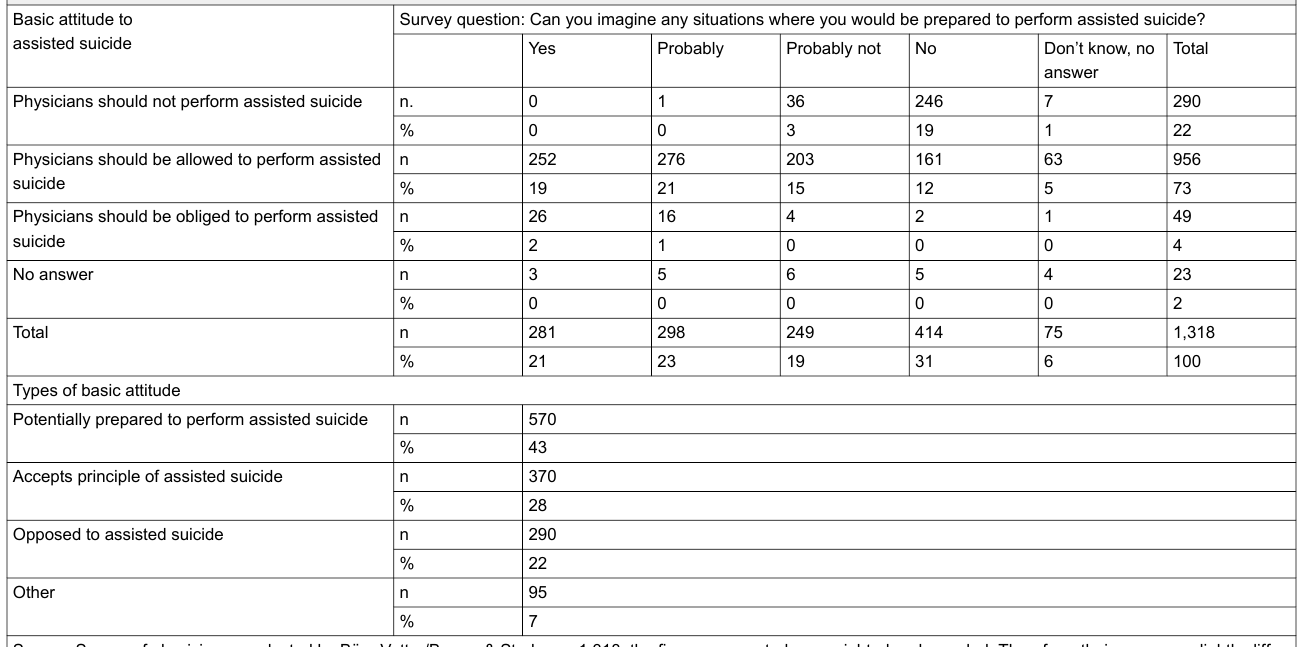
Table 2: Respondents’ readiness to perform assisted